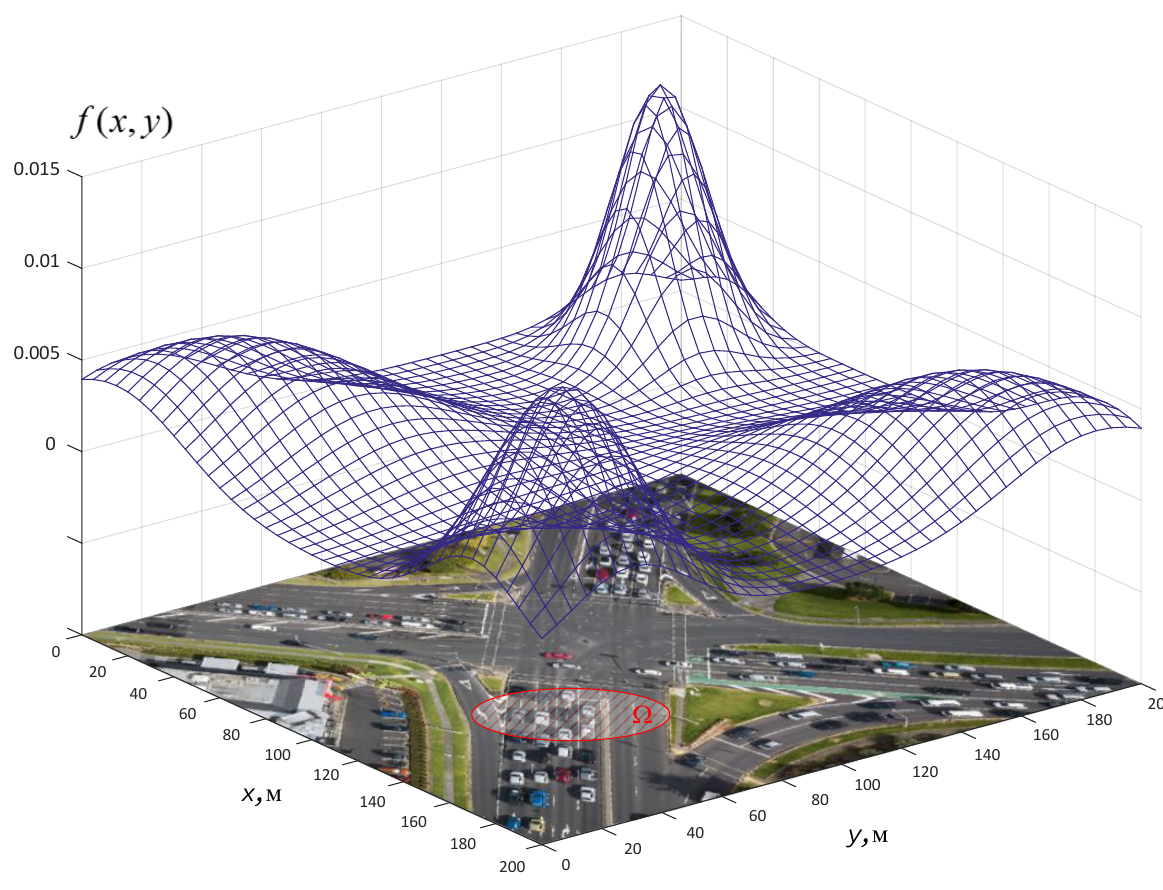
Figure 1. Network model within the boundaries of the intersection based on two-dimensional normal distributions.